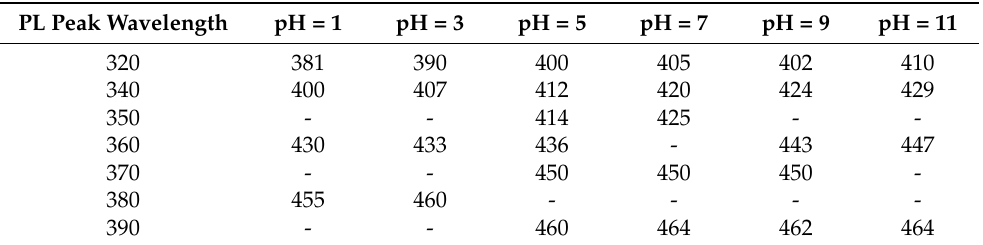
Table 1. The center wavelengths of PL peaks at different pH values corresponding to various excitation wavelengths.